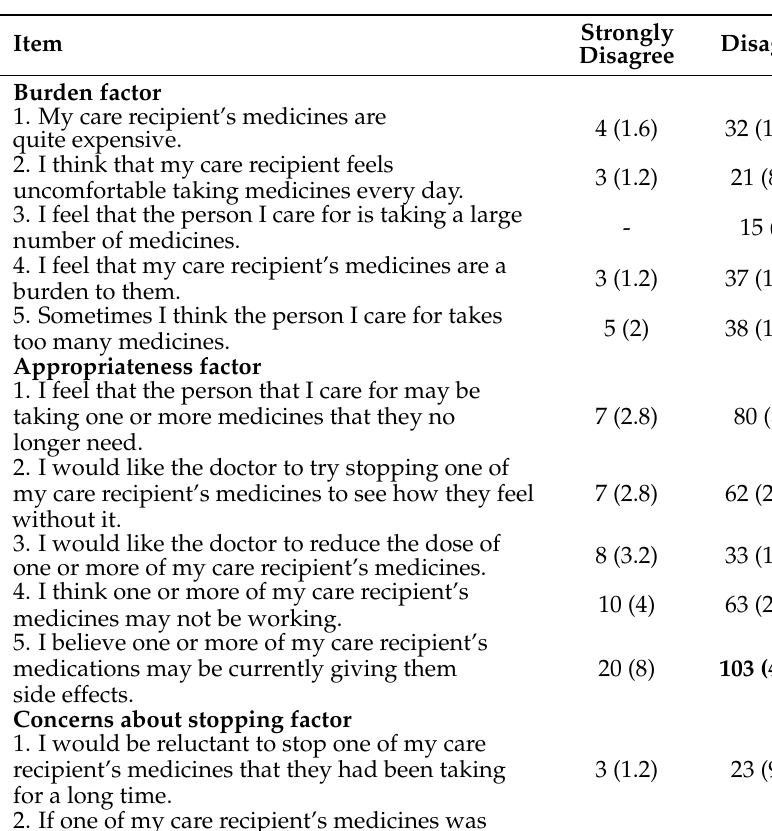
Table 4. Caregivers’ responses to the rPATD questionnaire about awareness of current medications use